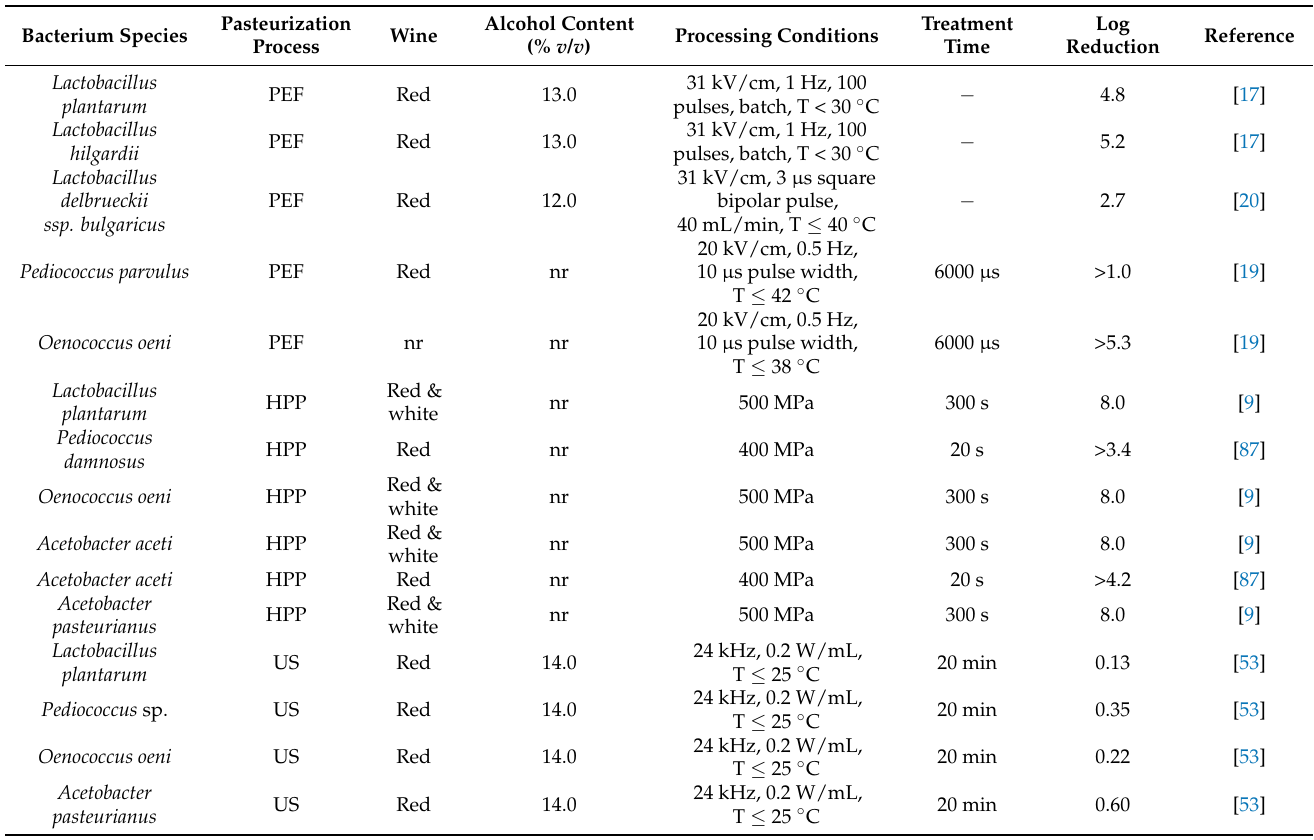
Table 3. Inactivation of bacteria in wine by non-thermal PEF, HPP and US technologies *. Bacterium